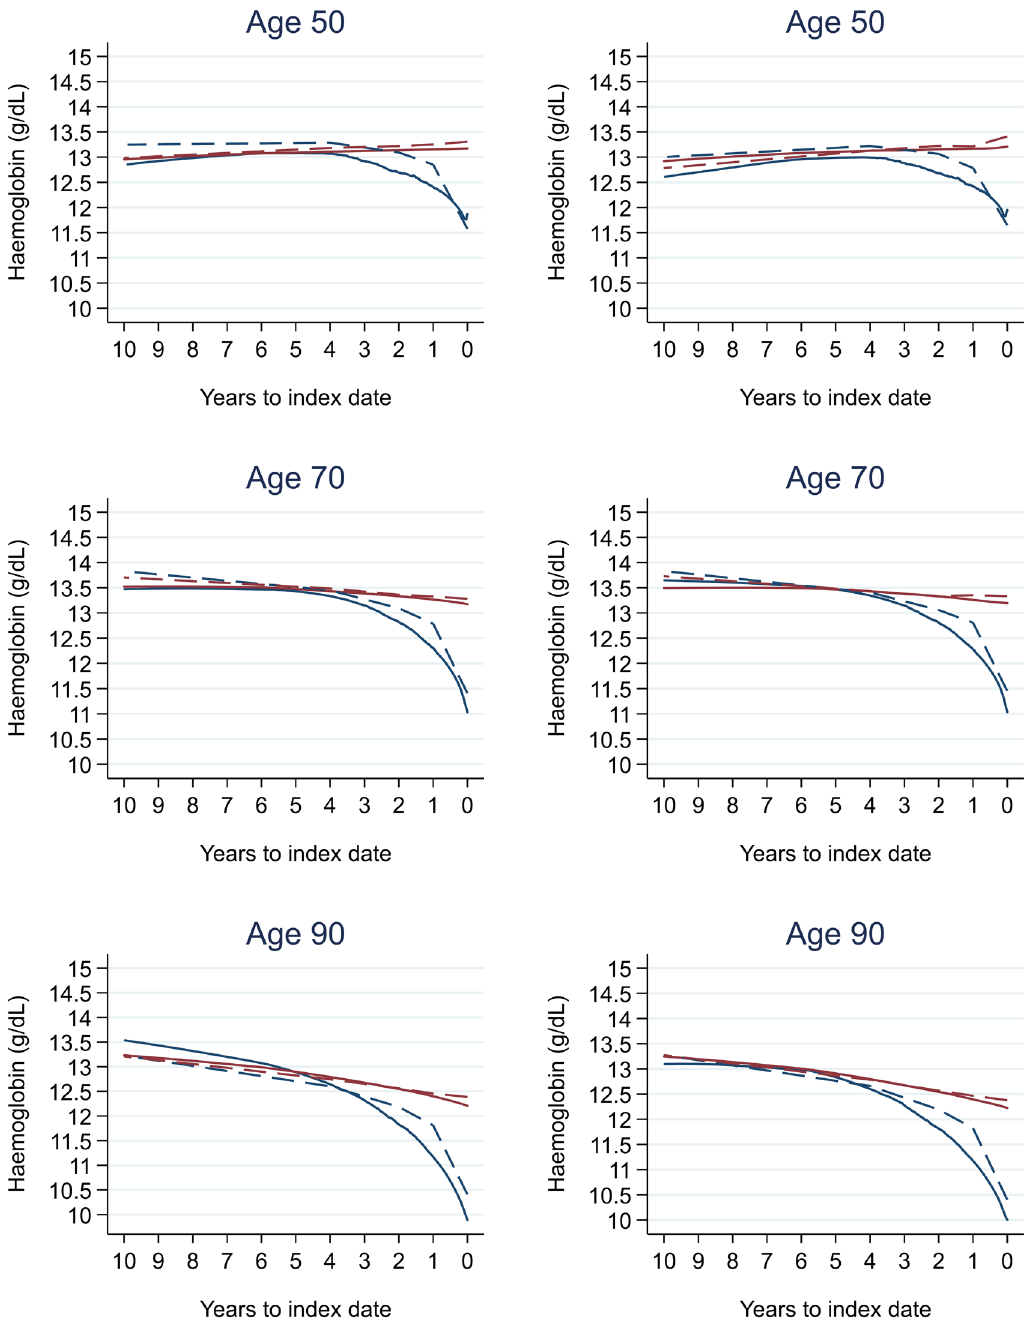
Figure 23. Haemoglobin trends for females by age at index 1,2 : unmatched (left) and matched (right). 1 Index date was the date of diagnosis for cases and a randomly selected date in the patient’s study period for controls. 2 LOWESS trends are age (+/- 3 years) and modelled (fixed effects) trends are taken at that specific age. Legend: colorectal cancer (blue line) and no cancer (red line). LOWESS trend (solid line) and modelled trend (dashed line).